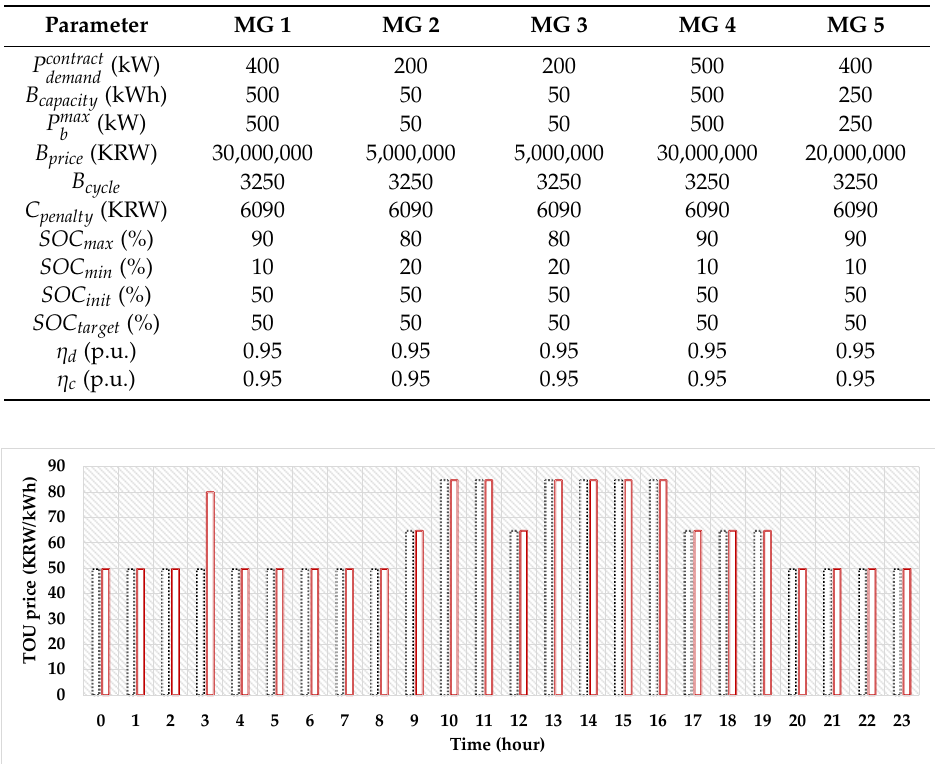
Table 2. Simulation conditions.